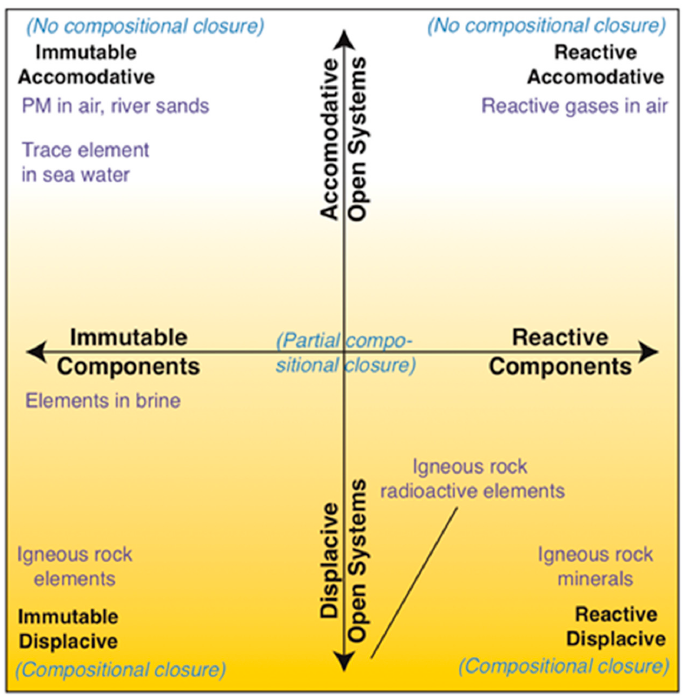
Figure 2. Compositional closure status in accommodative and displacive open systems with immu- table and with reactive components and examples